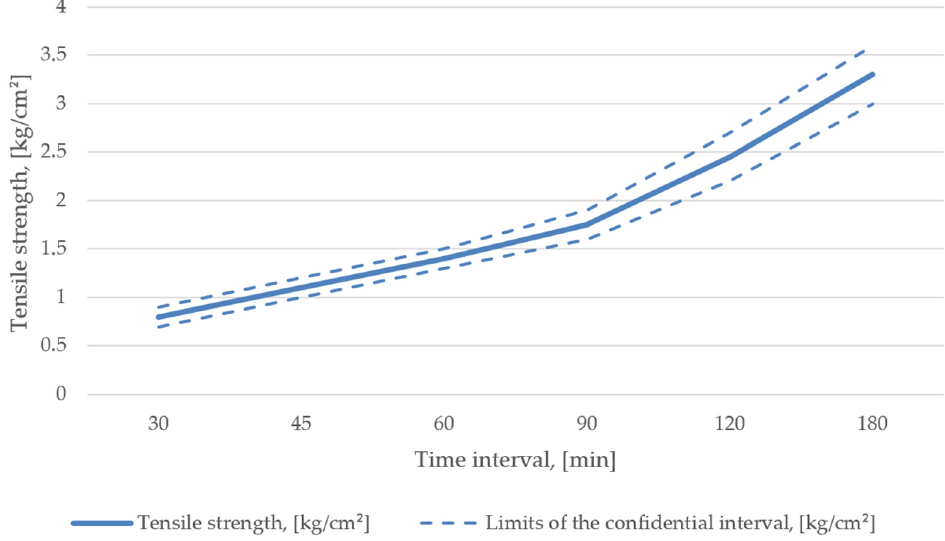
Figure 4. Mechanical properties of mixture recipe No. 1.